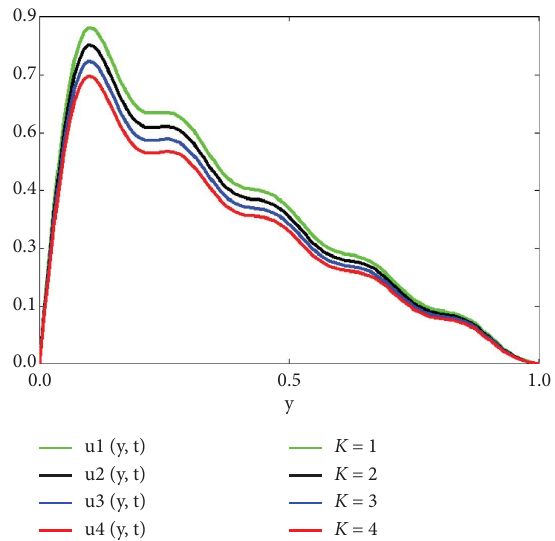
Figure 5: Te impact of diferent values of K on ψ